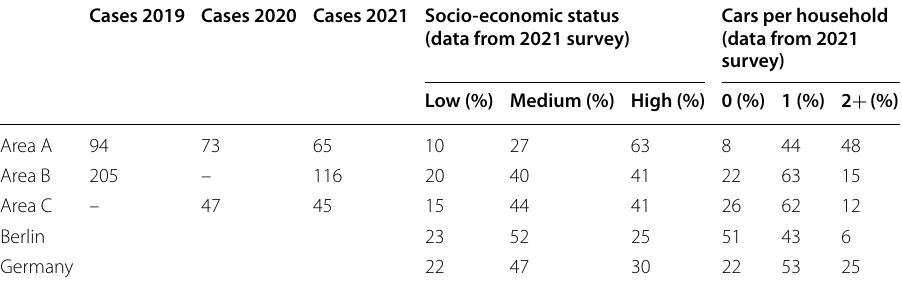
Table 2 Case numbers of survey waves and selected economic attributes of